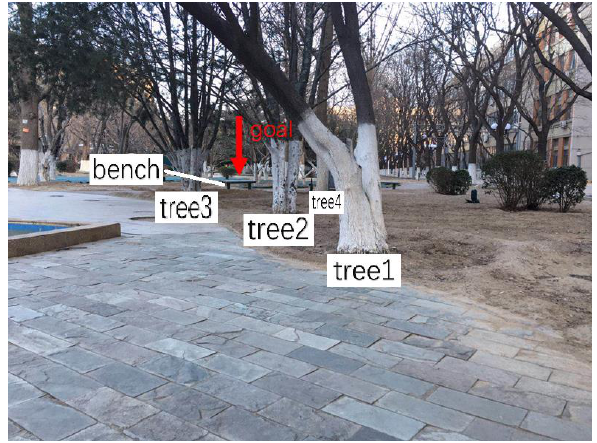
Figure 11. Experiment environment.